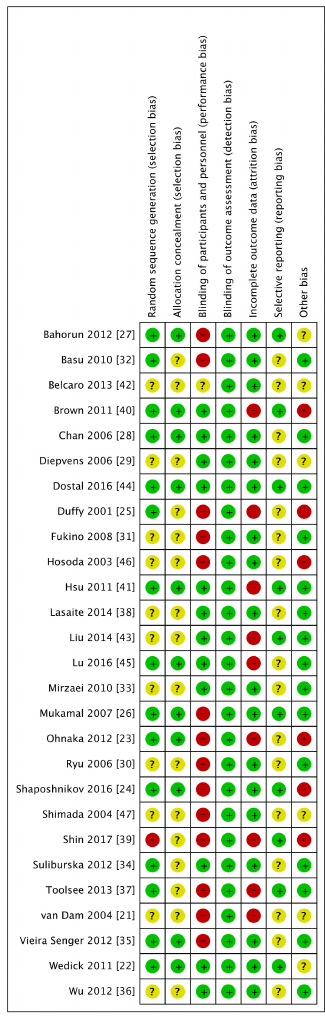
Figure 3. Risk of bias